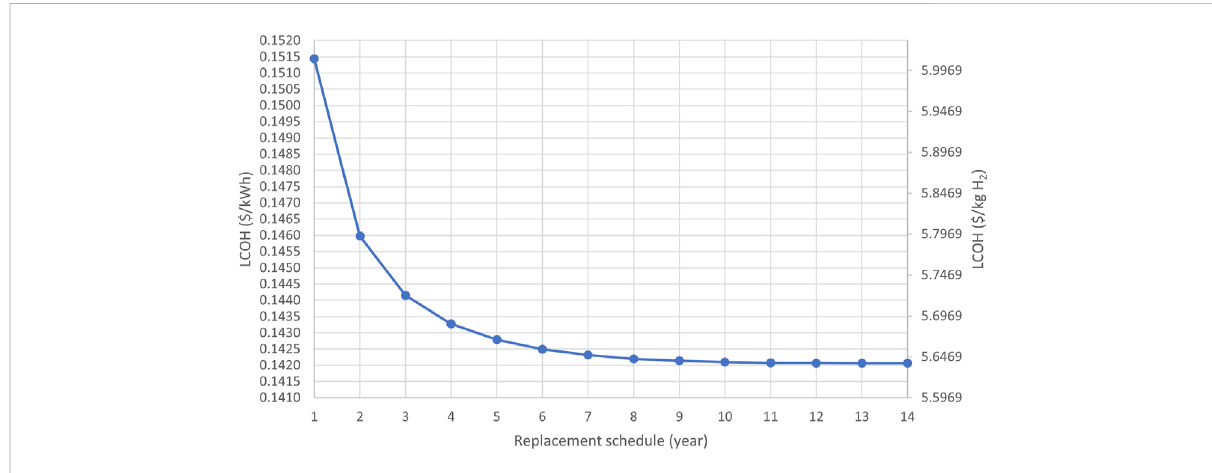
FIGURE 5 Minimum LCOHs for SOECs with different replacement